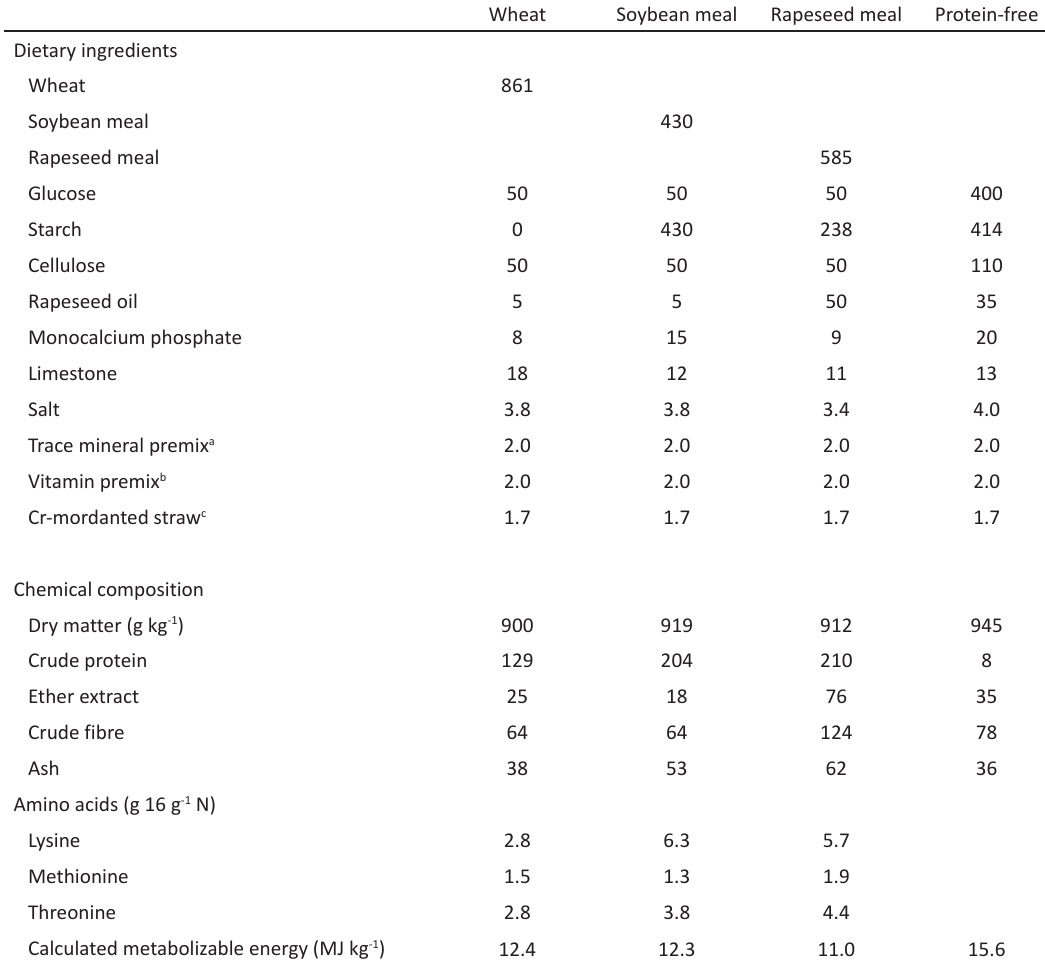
Table 2. Dietary ingredients (g kg -1 ) and chemical composition (g kg -1 dry matter, unless otherwise stated) of experimental diets used in the ileal digestibility measurements Wheat Soybean meal Rapeseed meal Protein-free Dietary ingredients Wheat